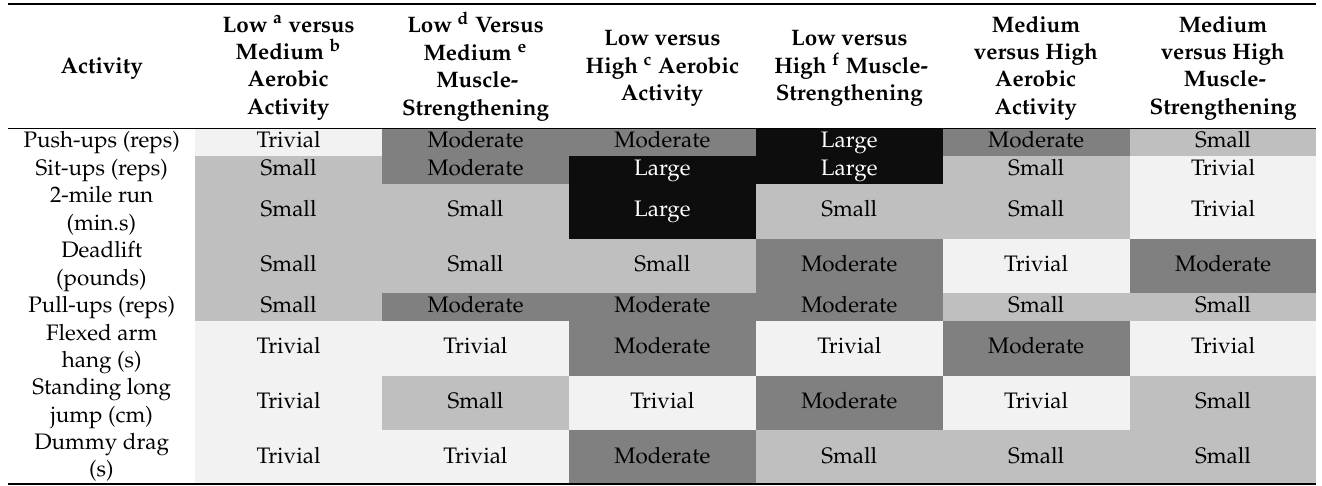
Table 5. Visual comparison of effect sizes by physical activity category for each fitness